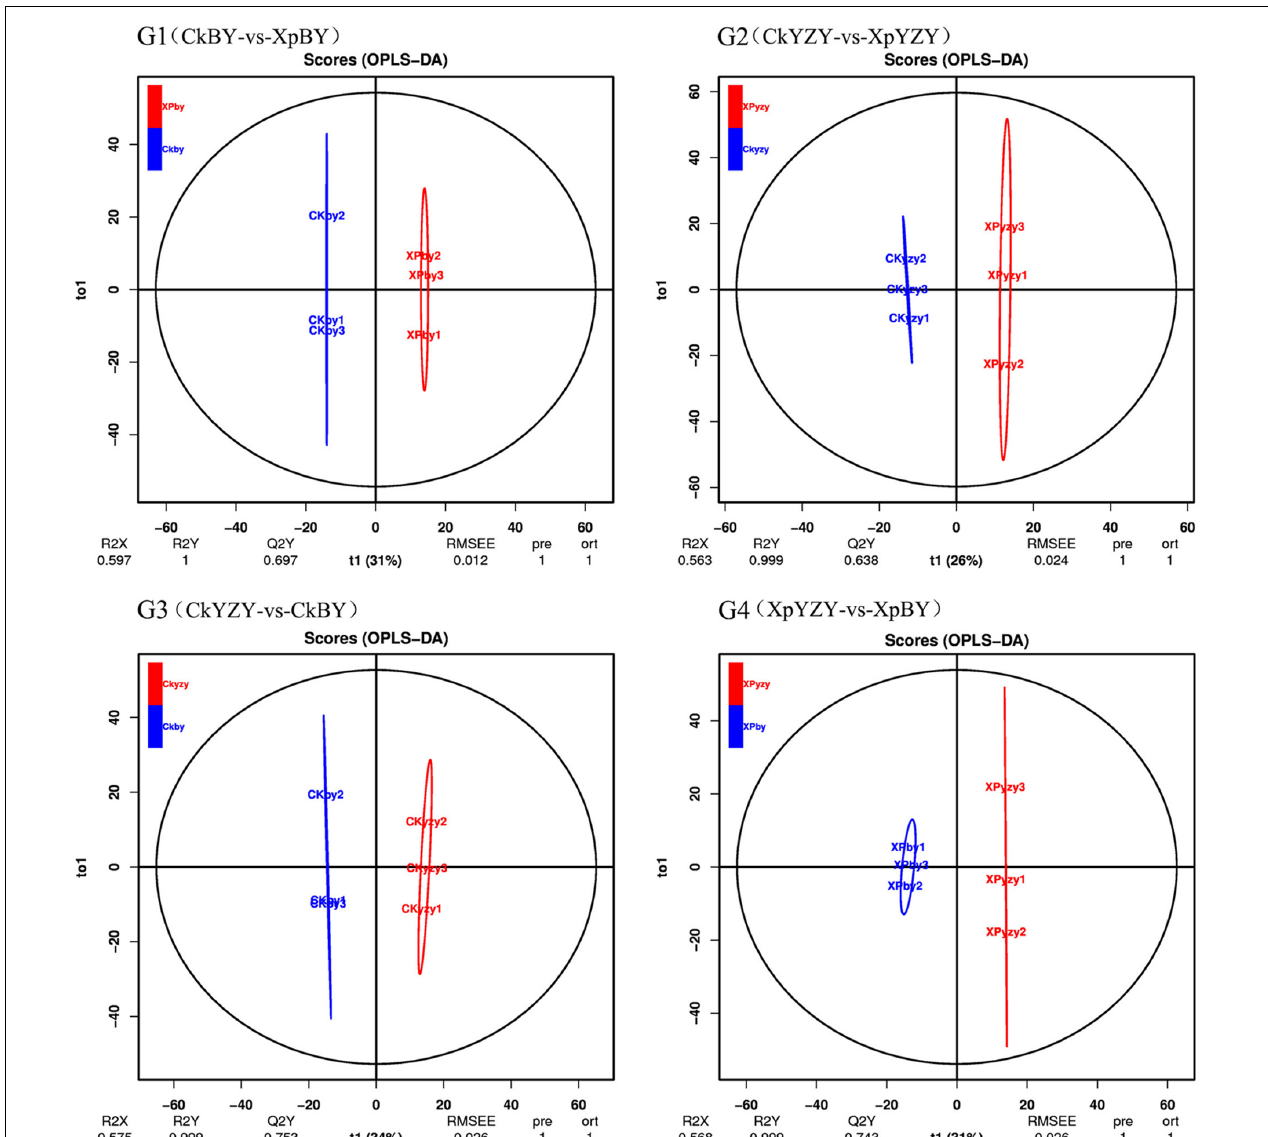
FIGURE 6 | The orthogonal partial least squares discriminant analysis model score plot of metabolic profiles in oat